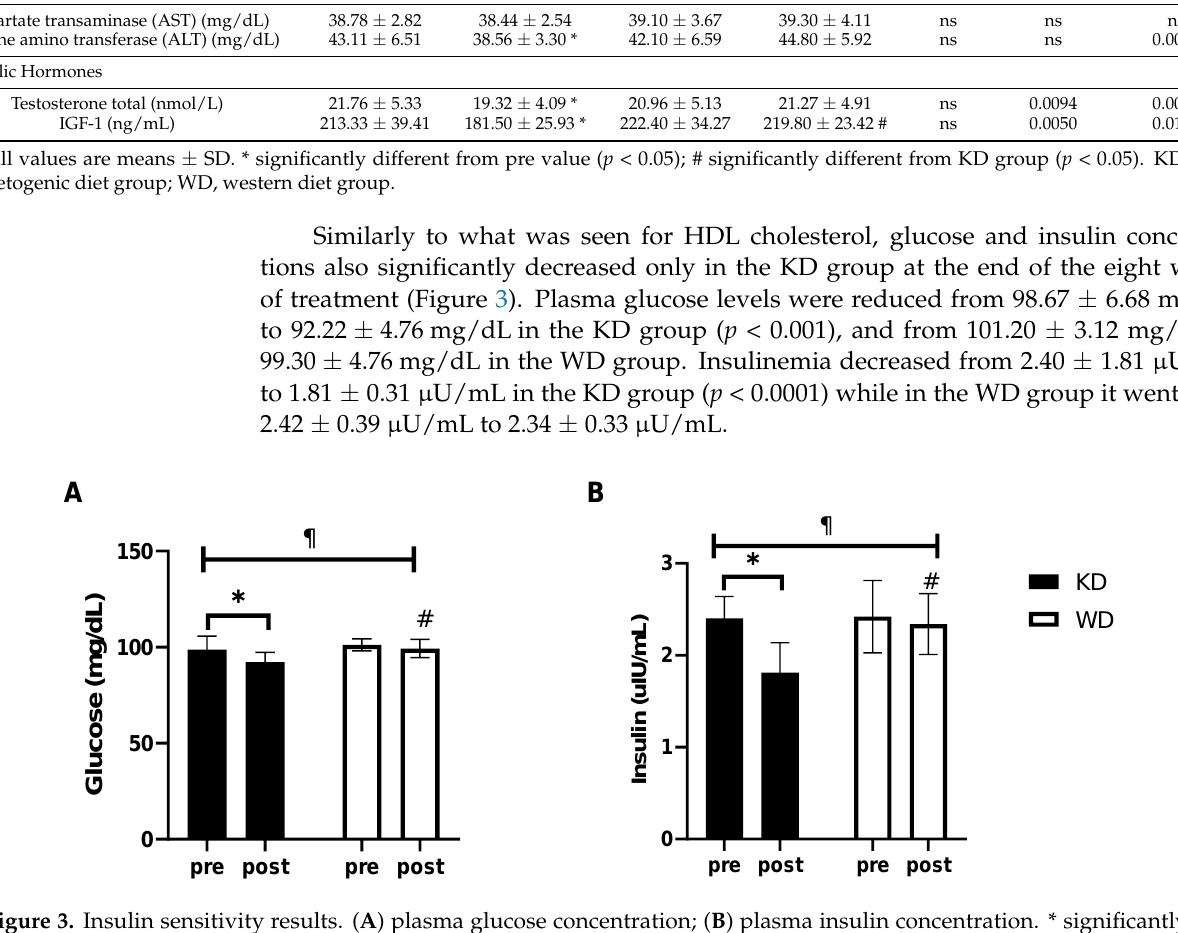
Figure 3. Insulin sensitivity results. ( A ) plasma glucose concentration; ( B ) plasma insulin concentration. * significantly different from pre-value ( p < 0.05); # significantly different from KD group ( p < 0.05); ¶ time × diet interaction ( p < 0.05). KD, ketogenic diet group; WD, western diet